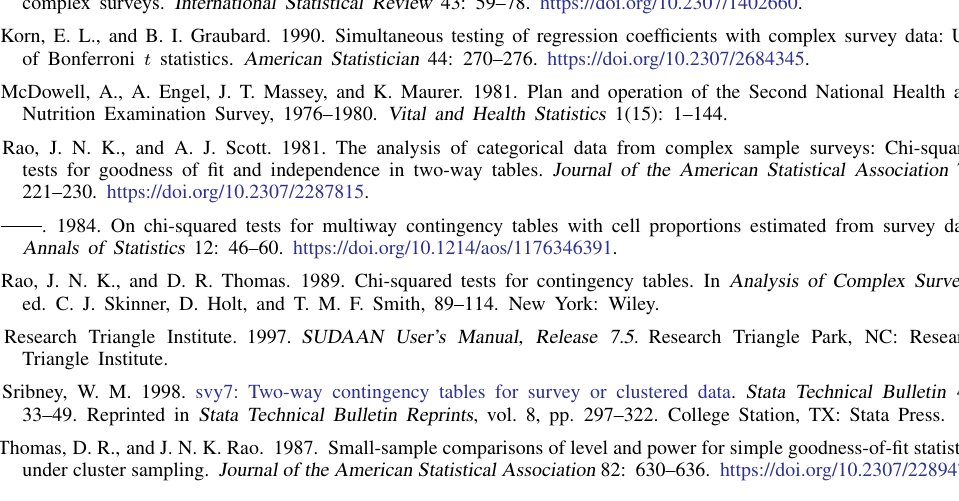
svy: tabulate twoway — Two-way tables for survey data 171 Adjusted F statistics are produced